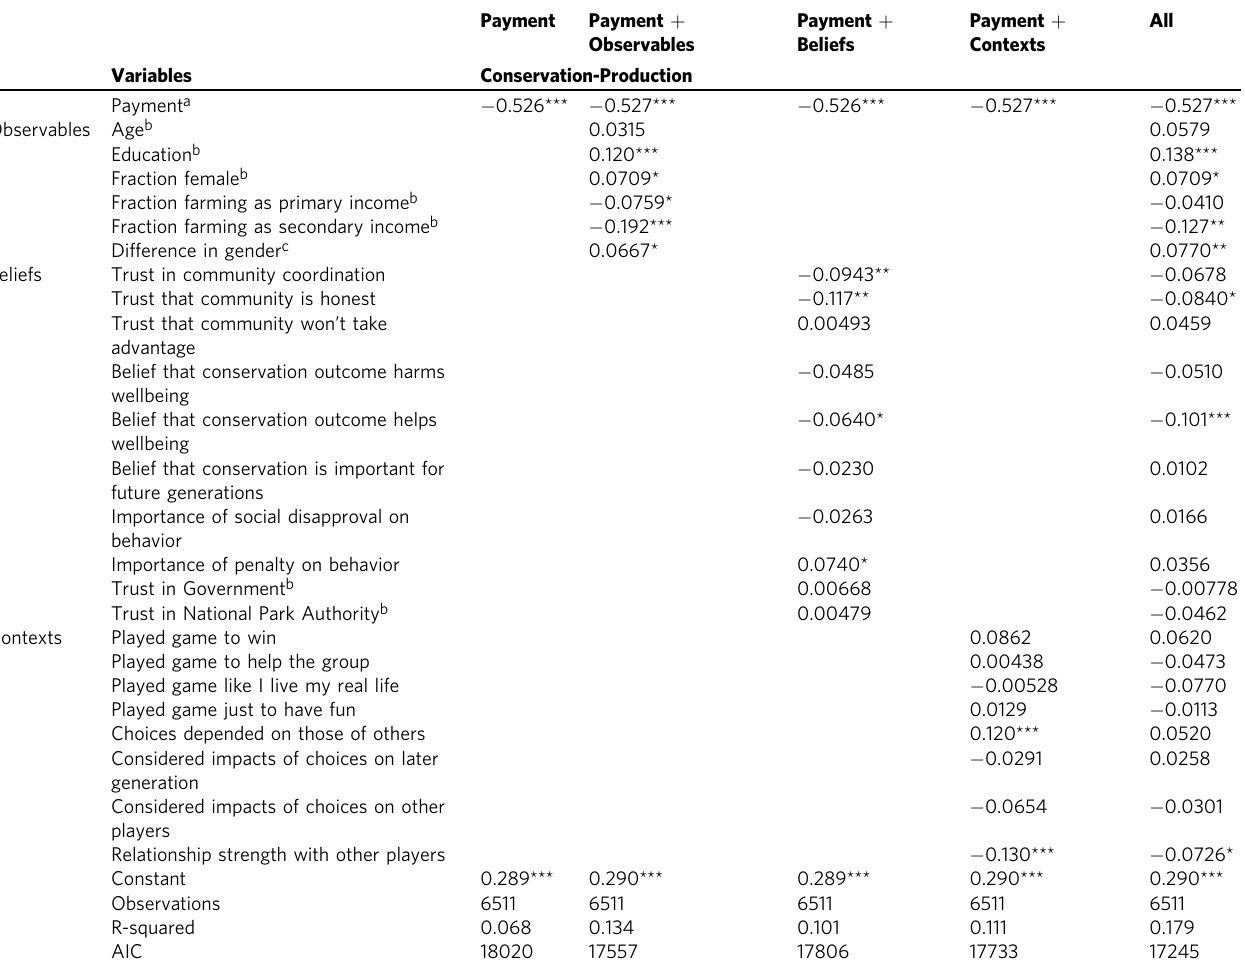
Table 2 Conservation-production outcomes on observables, beliefs, and context variables for 5-country